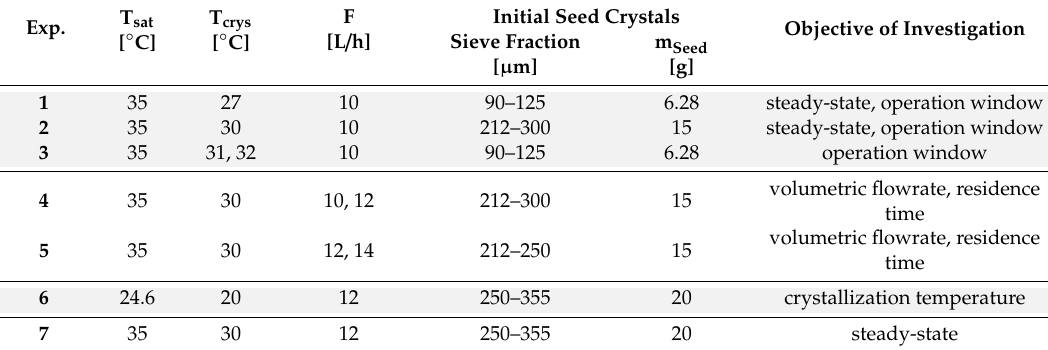
Table 1. Process conditions and objectives of all